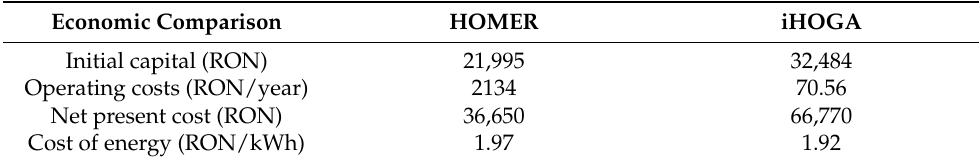
Table 15. Economic comparison for the two simulators (HOMER and iHOGA).